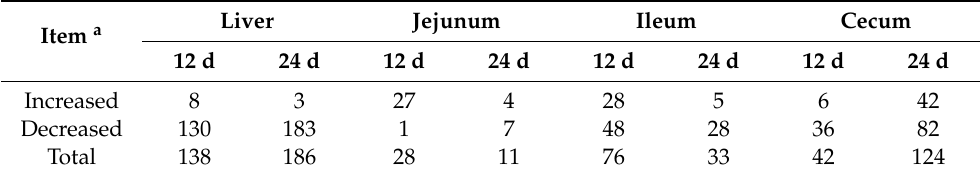
Table 2. The number of differential metabolites in the liver, jejunal, ileal, and cecal contents on day 12 and 24 of overfeeding.